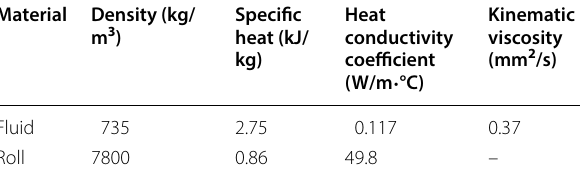
Table 4 Physical property parameters of the fluid and roll Material Density (kg/ m 3